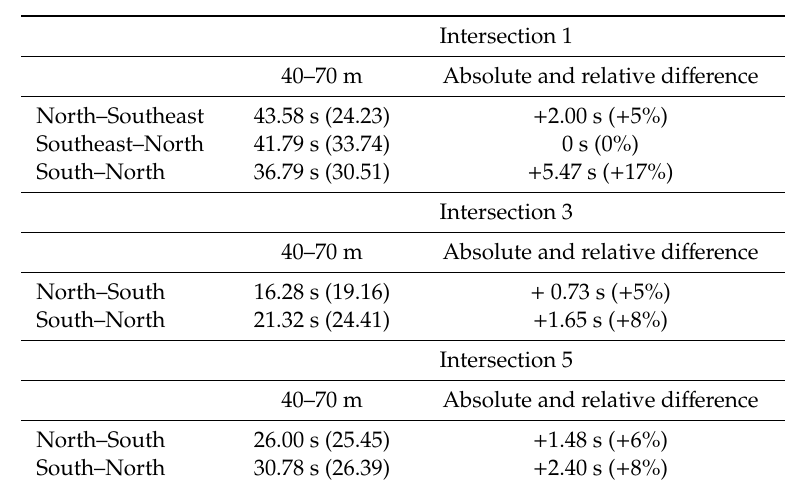
Table 4. Calculated delays for the 40–70 m bu ff er without application of the speed